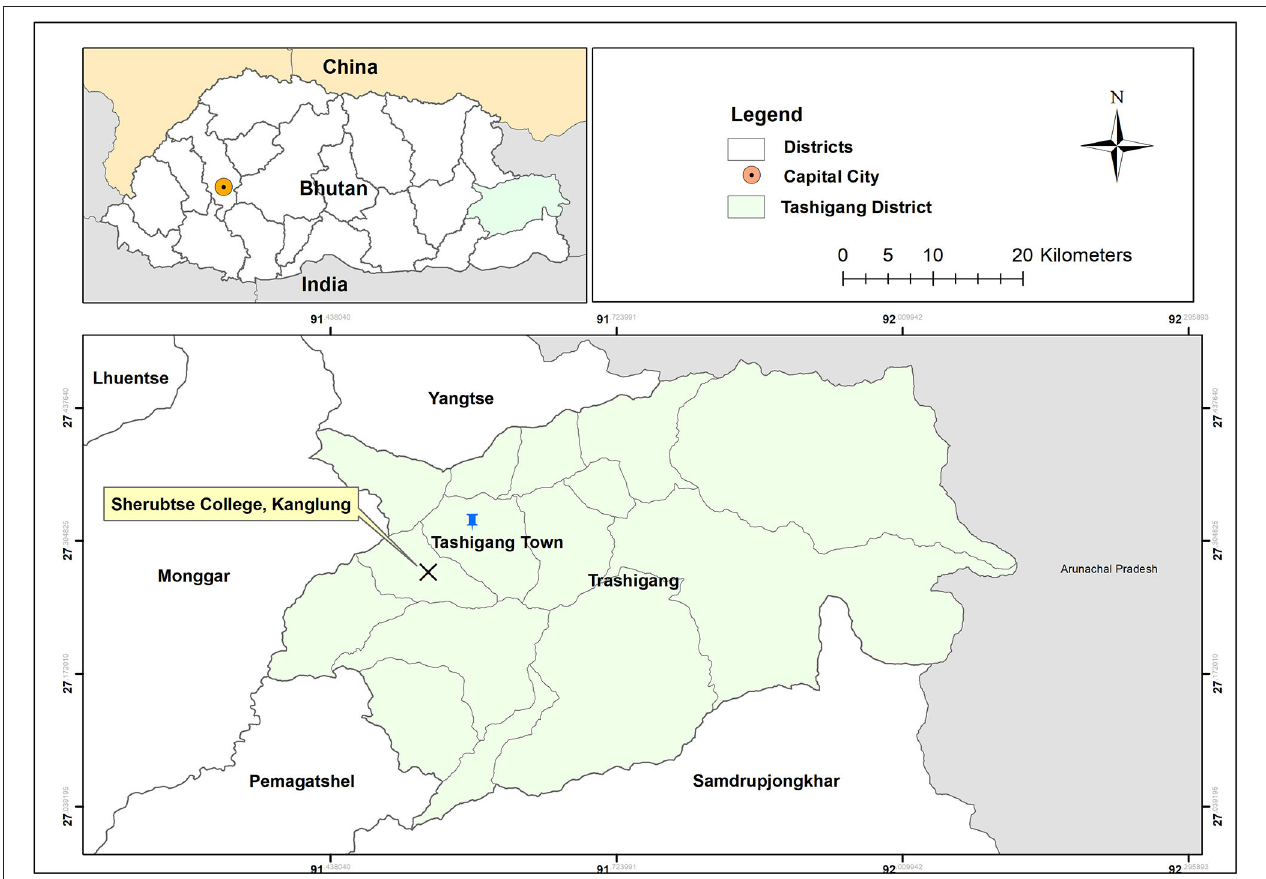
FIGURE 1 | Map of Sherubtse College, Kanglung, Trashigang District,